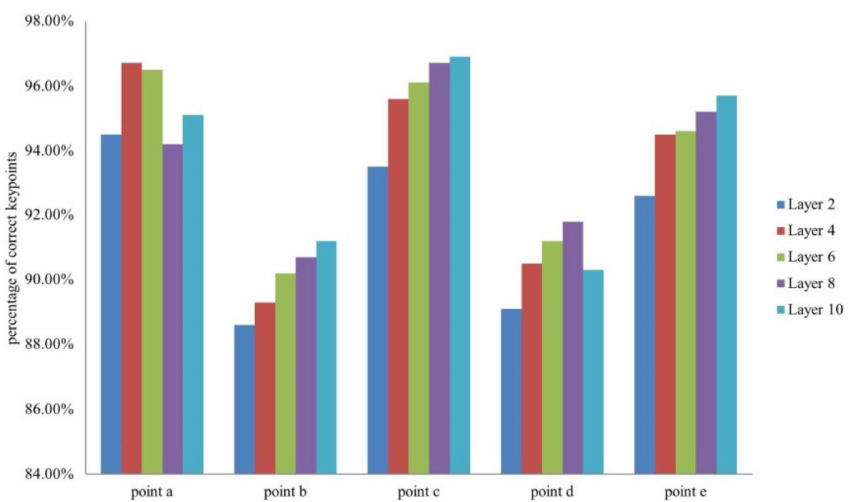
Figure 13. Feature point location results of different depth